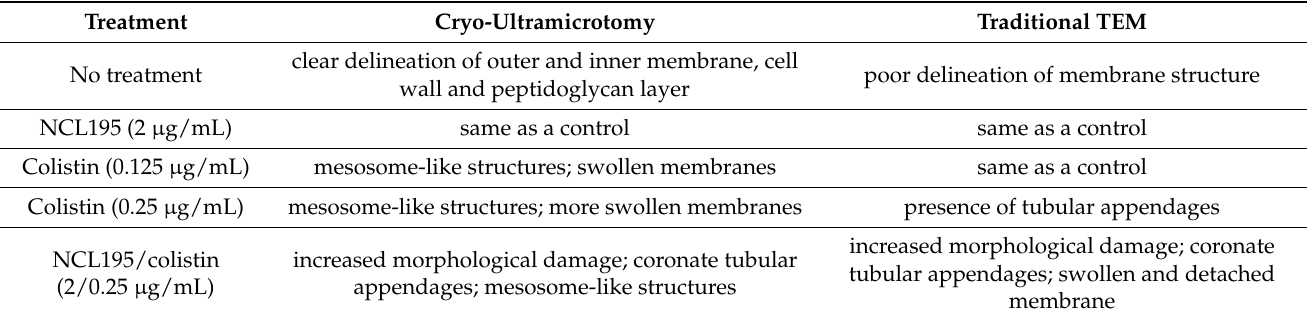
Table 2. Comparison of cryo-ultramicrotomy preparation and traditional TEM methods for visualizing the effect of drug treatments on Xen14 cell